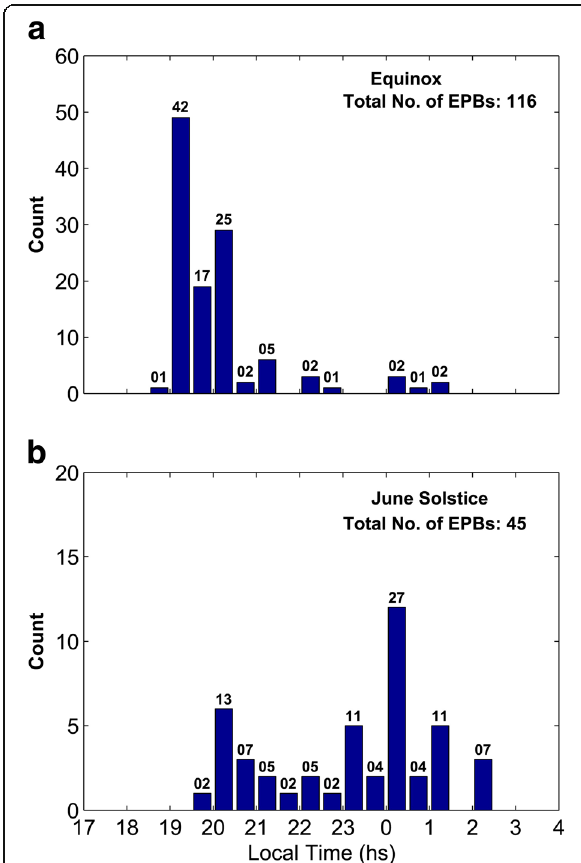
Fig. 6 Histogram showing the nighttime occurrence of freshly evolved EPBs over Kototabang during the a equinox and b June solstices from 2011 to 2012. The numbers shown on top of the histogram bars indicate percentages (after Ajith et al.